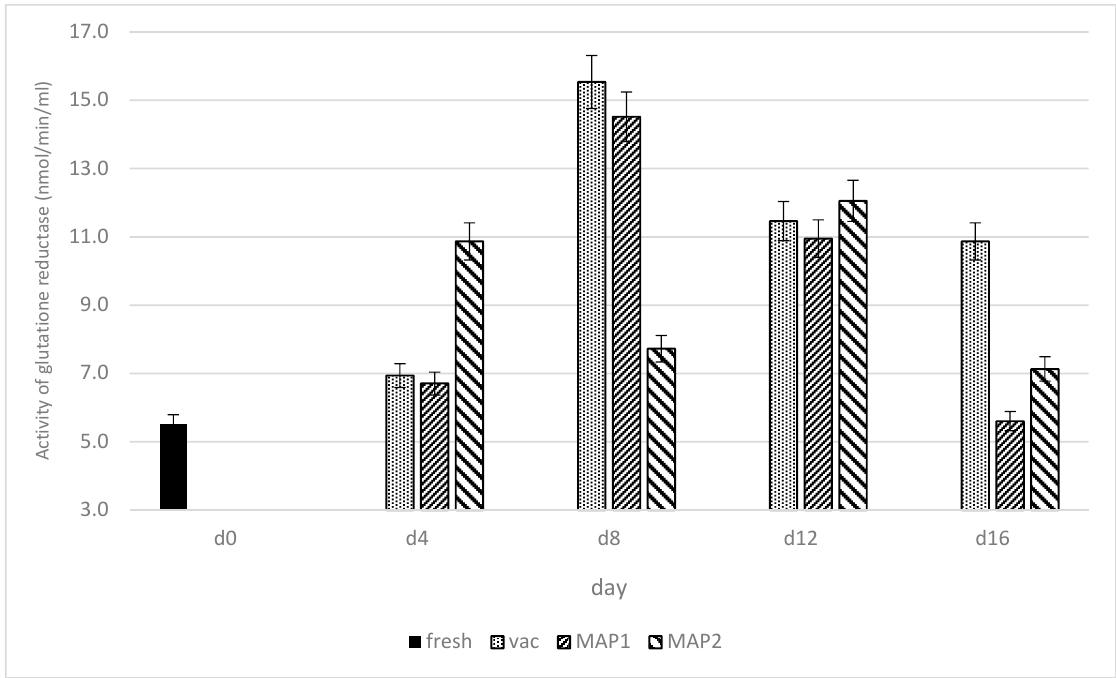
Figure 4. Changes in the activity (nmol/min/mL) of glutathione reductase (GR) in ostrich muscles as influenced by the type of packaging and storage time in refrigeration.